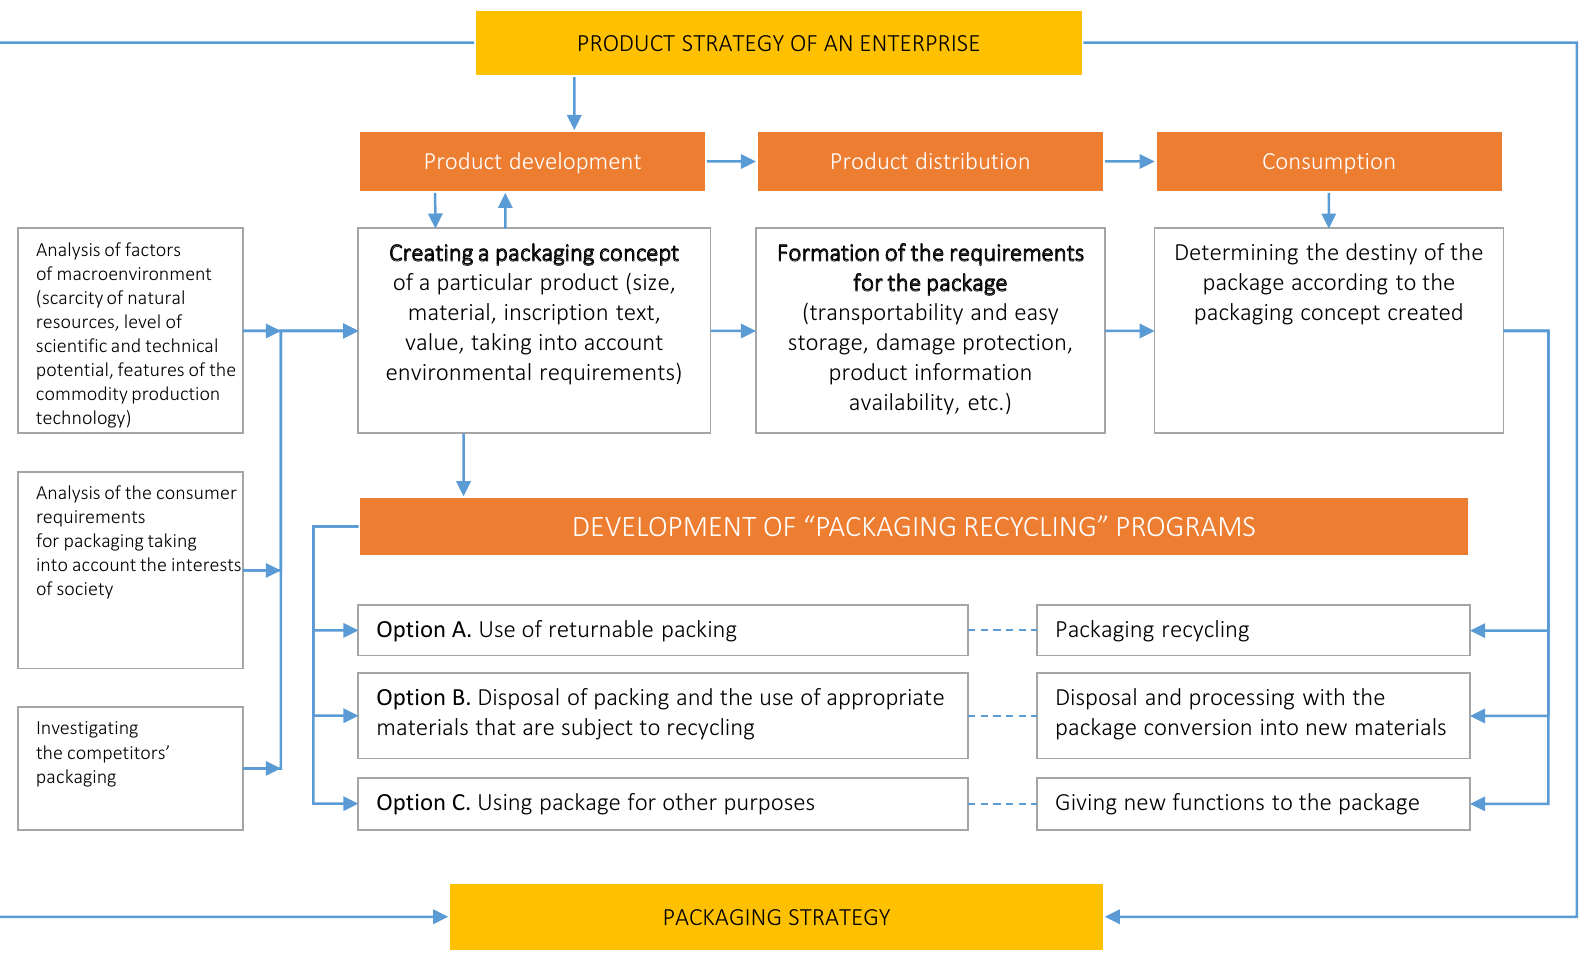
Figure 4. The product strategy of an enterprise and the packaging strategy